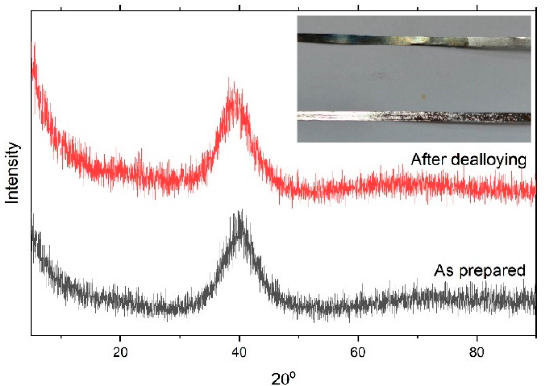
Figure 1. XRD pattern of the Ni 60 Pd 20 P 16 B 4 glassy alloy ribbon sample. The inset shows photo images of the ribbon sample before and after the dealloying experiment.